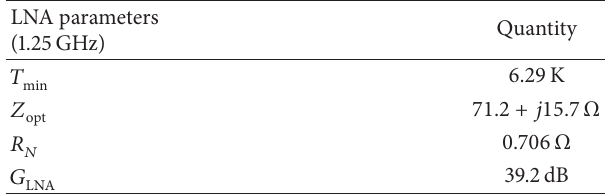
Table 5: Parameters for the